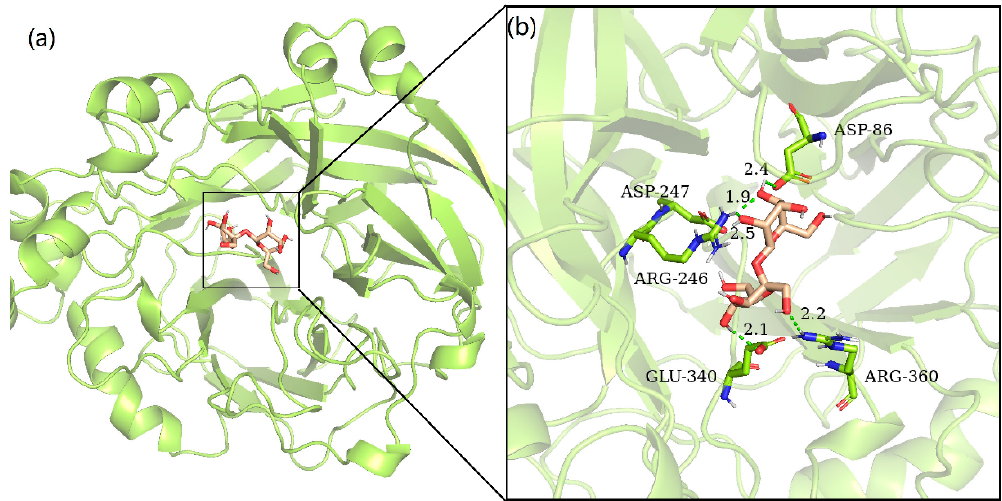
Figure 6. Active pocket for sucrose docking to levansucrase. ( a ) Structural alignment of the predicted 3D structures and molecular docking of BM-2 levansucrase using the crystal structure of B. subtilis levansucrase (PDB ID: 3byl) (green) as a template. Cartoon representation of BM-2 levansucrase structure with a view into the funnel, sucrose as the ligand molecule shown as a stick model with the carbon skeleton marked with pink and the hydroxyl group marked with red. ( b ) Magnified view of the molecular docking of the catalytic active cavity of the black box in Figure 6A. Details of the BM-2 levansucrase contacts in the substrate bond complex, coupling with the nucleophilic, transition stabilizer, and general acid residues. The selected residues Asp86 (green), Asp247 (green), Arg246 (green), and Glu340 (green) and Arg360 (green) were predicted to localize to the surface of the active cavity. The dashed green line is the hydrogen bond with the value of the bond length.